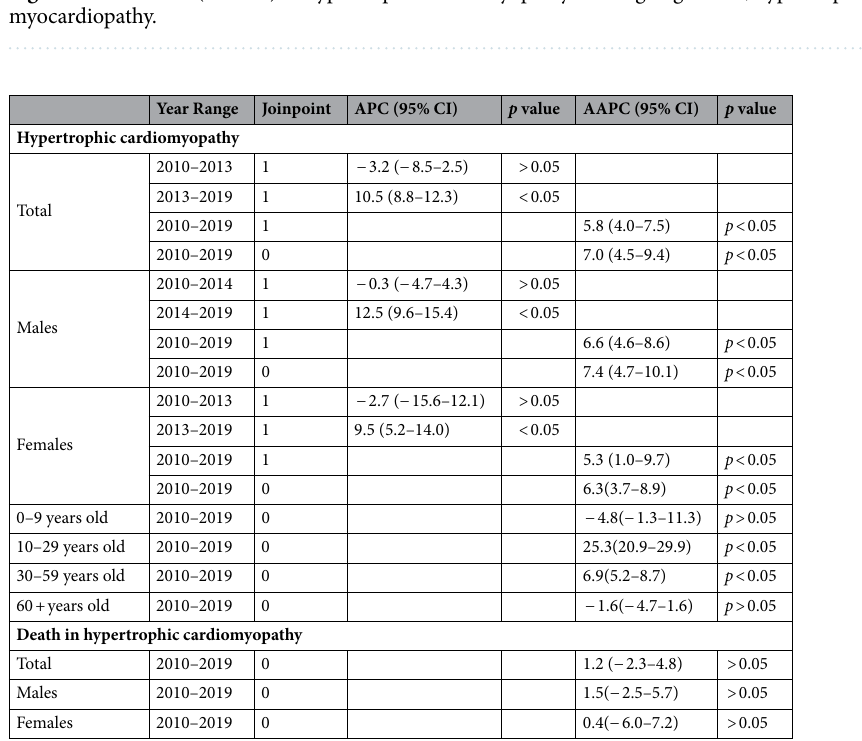
Table 2. Temporal trends of incidence of hypertrophic cardiomyopathy. HCM hypertrophic myocardiopathy, APC Annual percentage change, AAPC average annual percentage change.